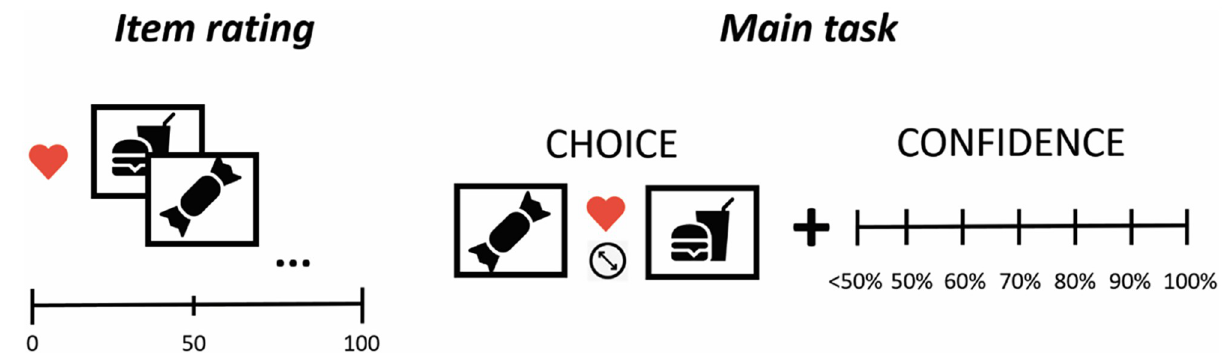
Fig 3. Experiment 2 task design. First, participants rated 72 food items based on their preference of winning the item. In the main task, each trial consisted of a forced choice between 2 items based on either participants’ preference (value-based condition) or stimulus size (perceptual condition) followed by a confidence